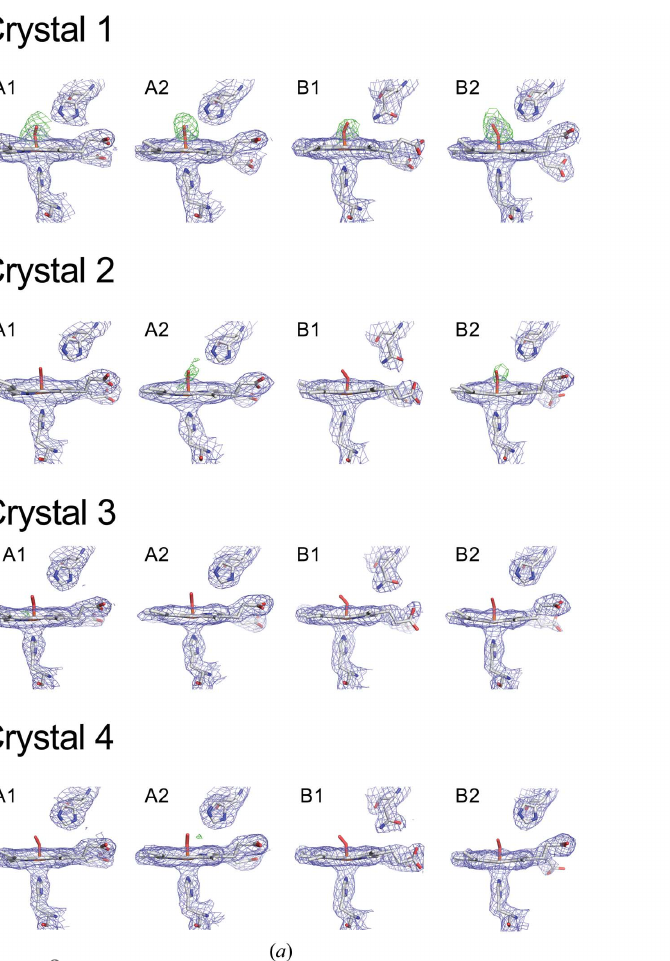
Figure 2 Determination of the oxygen saturation fraction of each subunit. ( a ) Electron densities superposed on the ligand sites of each subunit. The 2 F o (cid:2) F c maps (blue, contoured at 1.0 (cid:2) ) and the oxygen-omitted F o (cid:2) F c maps (green, contoured at 2.5 (cid:2) ) are represented with stick models of the heme, oxygen, proximal histidine and distal histidine. ( b ) The residues to which the atoms subjected to the B -factor analysis belong are shown as stick models. ( c ) Transition of oxygen saturation in each subunit (vertical axis). The overall oxygen saturation of the crystals (horizontal axis) was determined as in Fig.